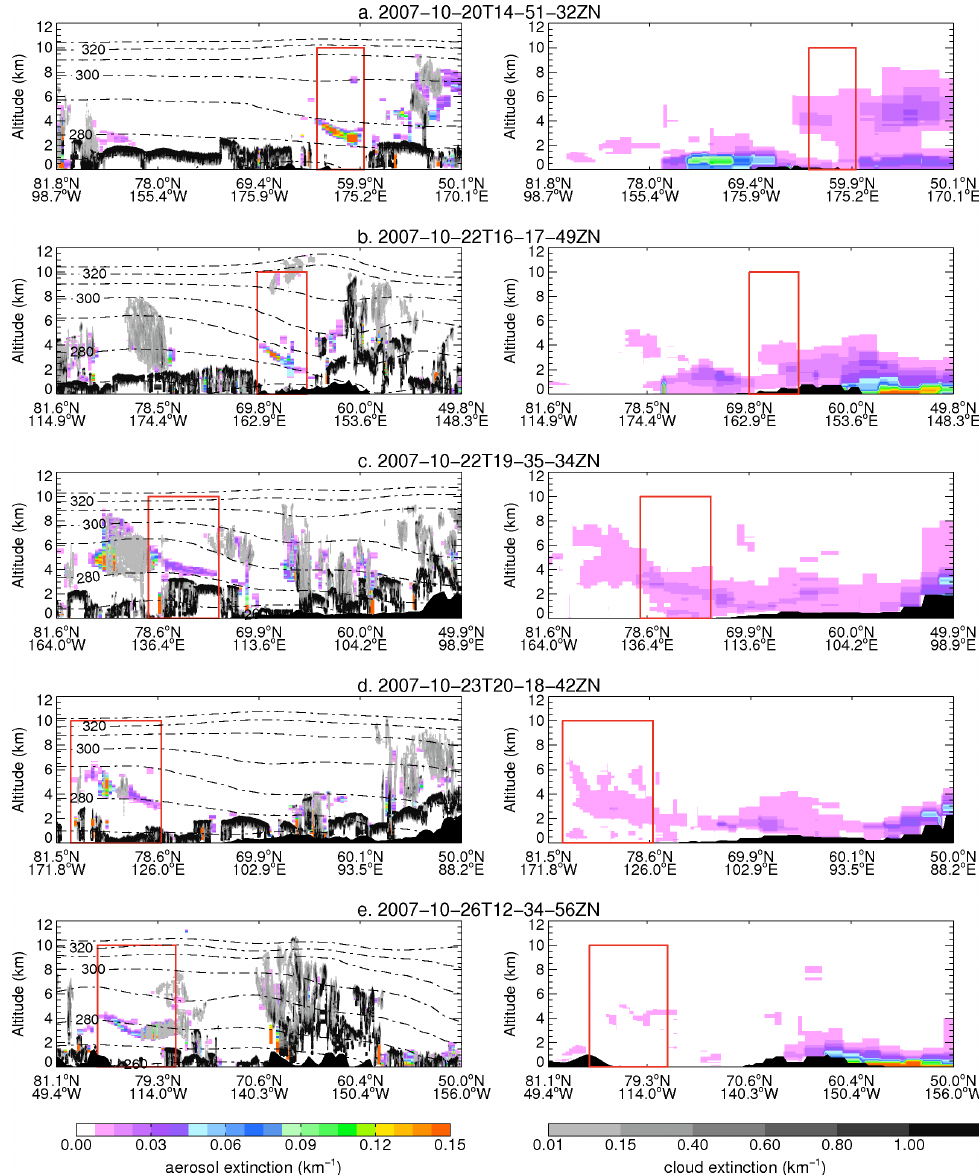
Figure 11. Same as Figure 2, for a subset of five major plume cross sections for the October 20-27 event. Fig. 11. Same as Fig. 2, for a subset of five major plume cross sections for the 20–27 October 2007